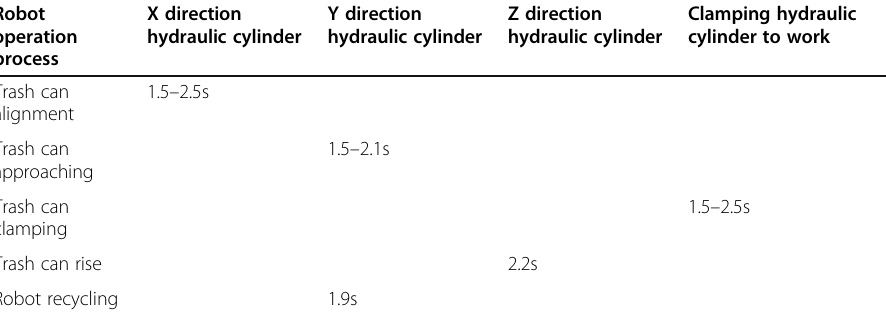
Table 5 Working hours of hydraulic cylinders in garbage collection